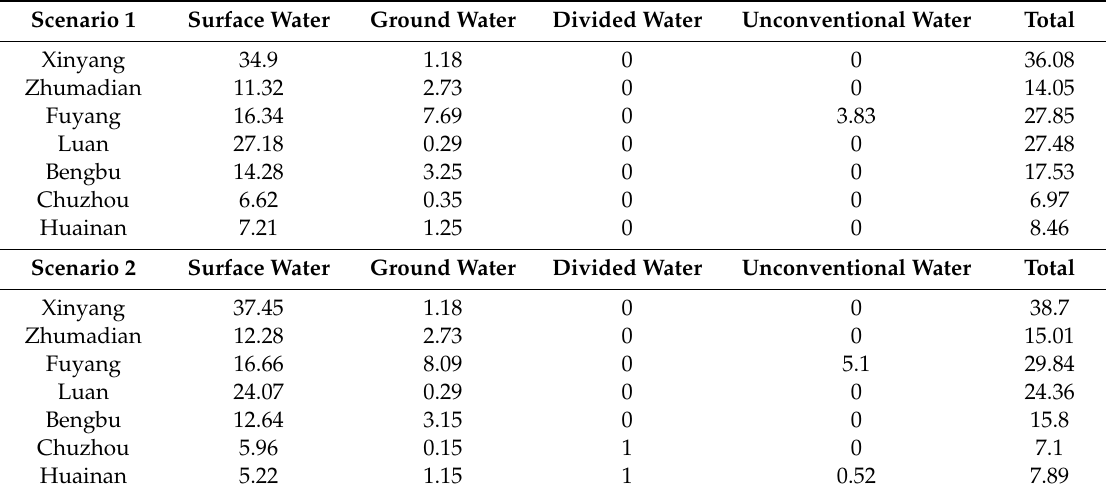
Table 3. Water supply of each water source in Huaihe River Basin in 2020 and 2050 (10 8 m 3 ). Scenario 1 Surface Water Ground